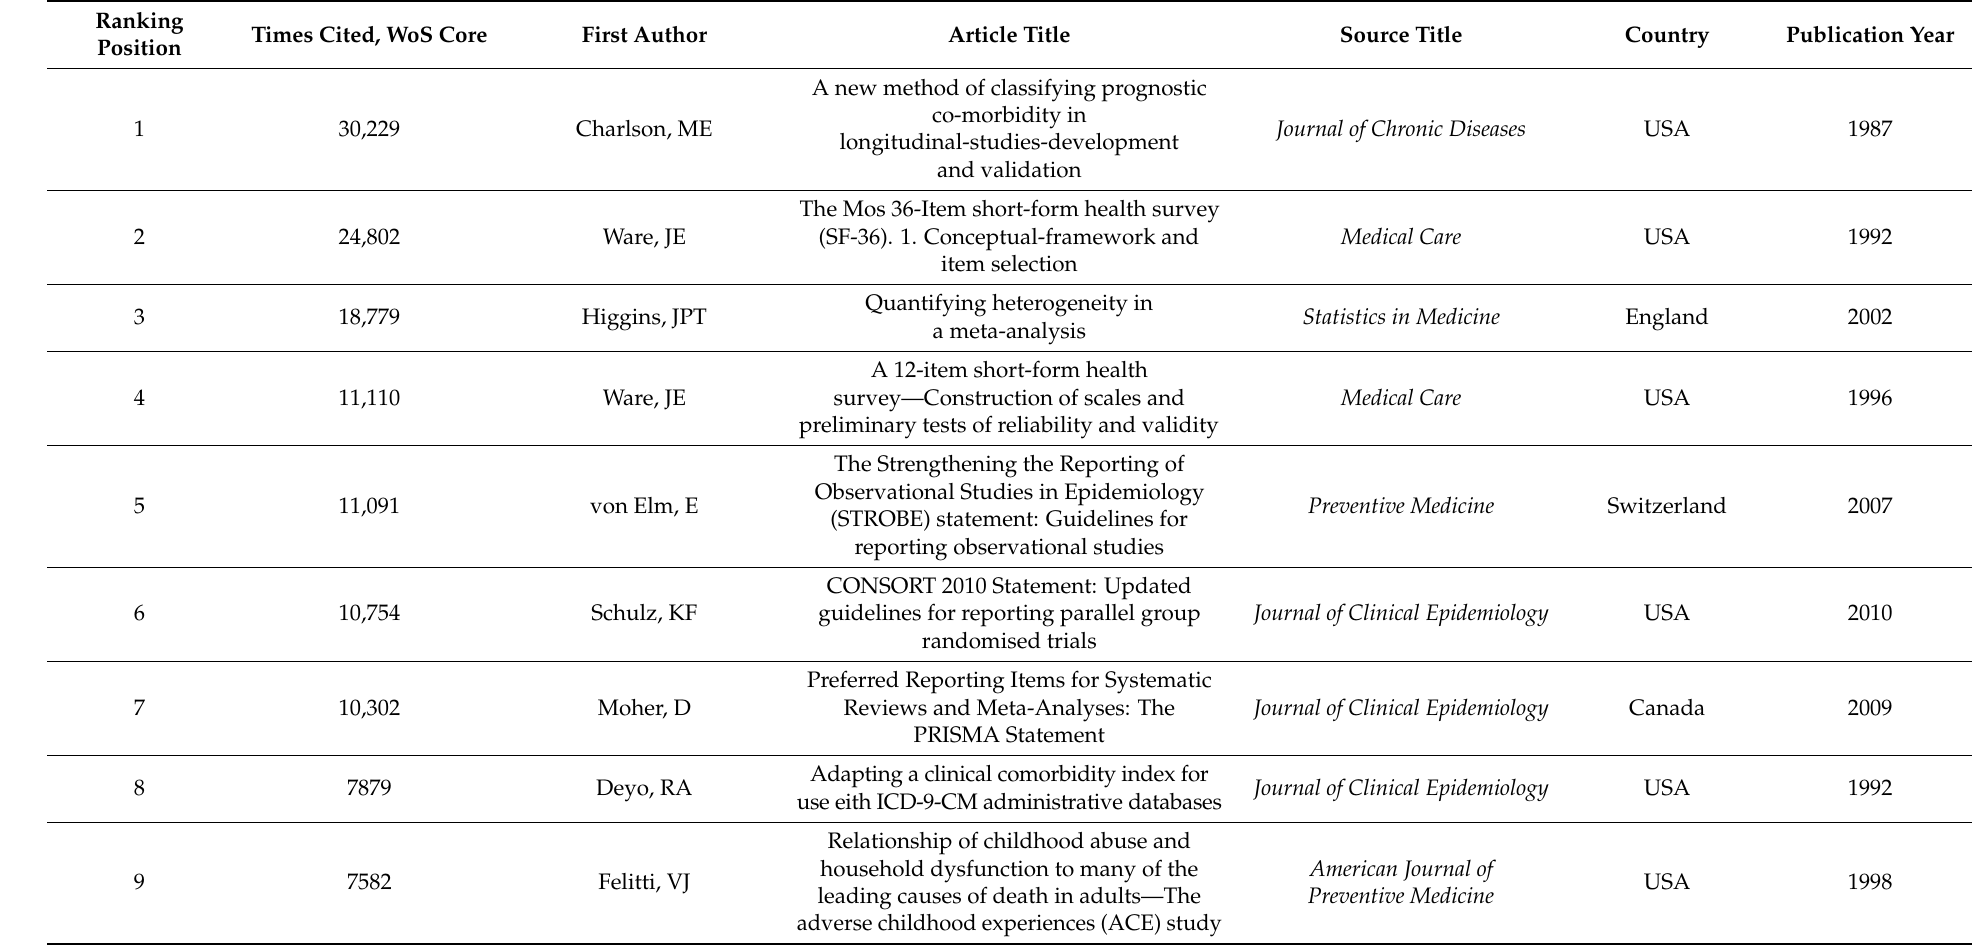
Table 1. The top 100 articles with most total citations in Public, Environmental & Ocupational Health